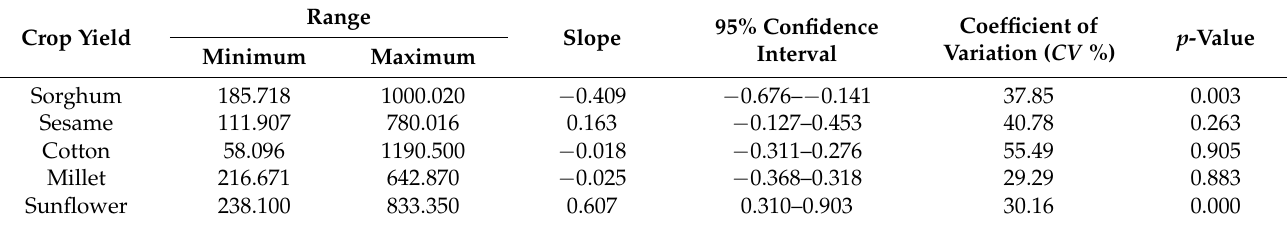
Table 3. Estimated slope of linear regression for the annual yield trends for five crops (sesame, sorghum, cotton, millet, and sunflower) in Gedaref state, Sudan from